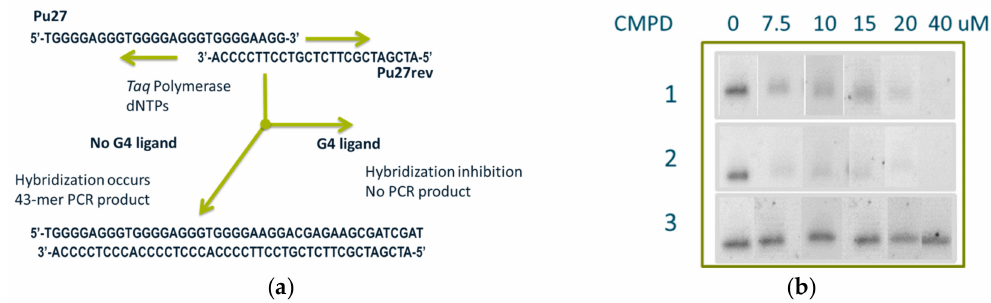
Figure7. PCR-stopassay. ( a )Schematicoftheassay: PrimingofPu27c-mycG4templateamplificationby Pu27rev oligonucleotides, which was complementary to the 3 (cid:48) end portion of C-myc G4. Hybridization occurred if no G-quartet structure formed and a 43-mer extended primer was generated. If the G-Quartet was stabilized by the added small-moleculethen hybridization and subsequent primer extension were inhibited. ( b ) A dose-dependent reduction in quantity of primer extension product was observed with Compounds 1 and 2 , whereas no inhibition was observed with Compound 3 , which was used as a negative control (Figure S1). Full gels are presented in Figure